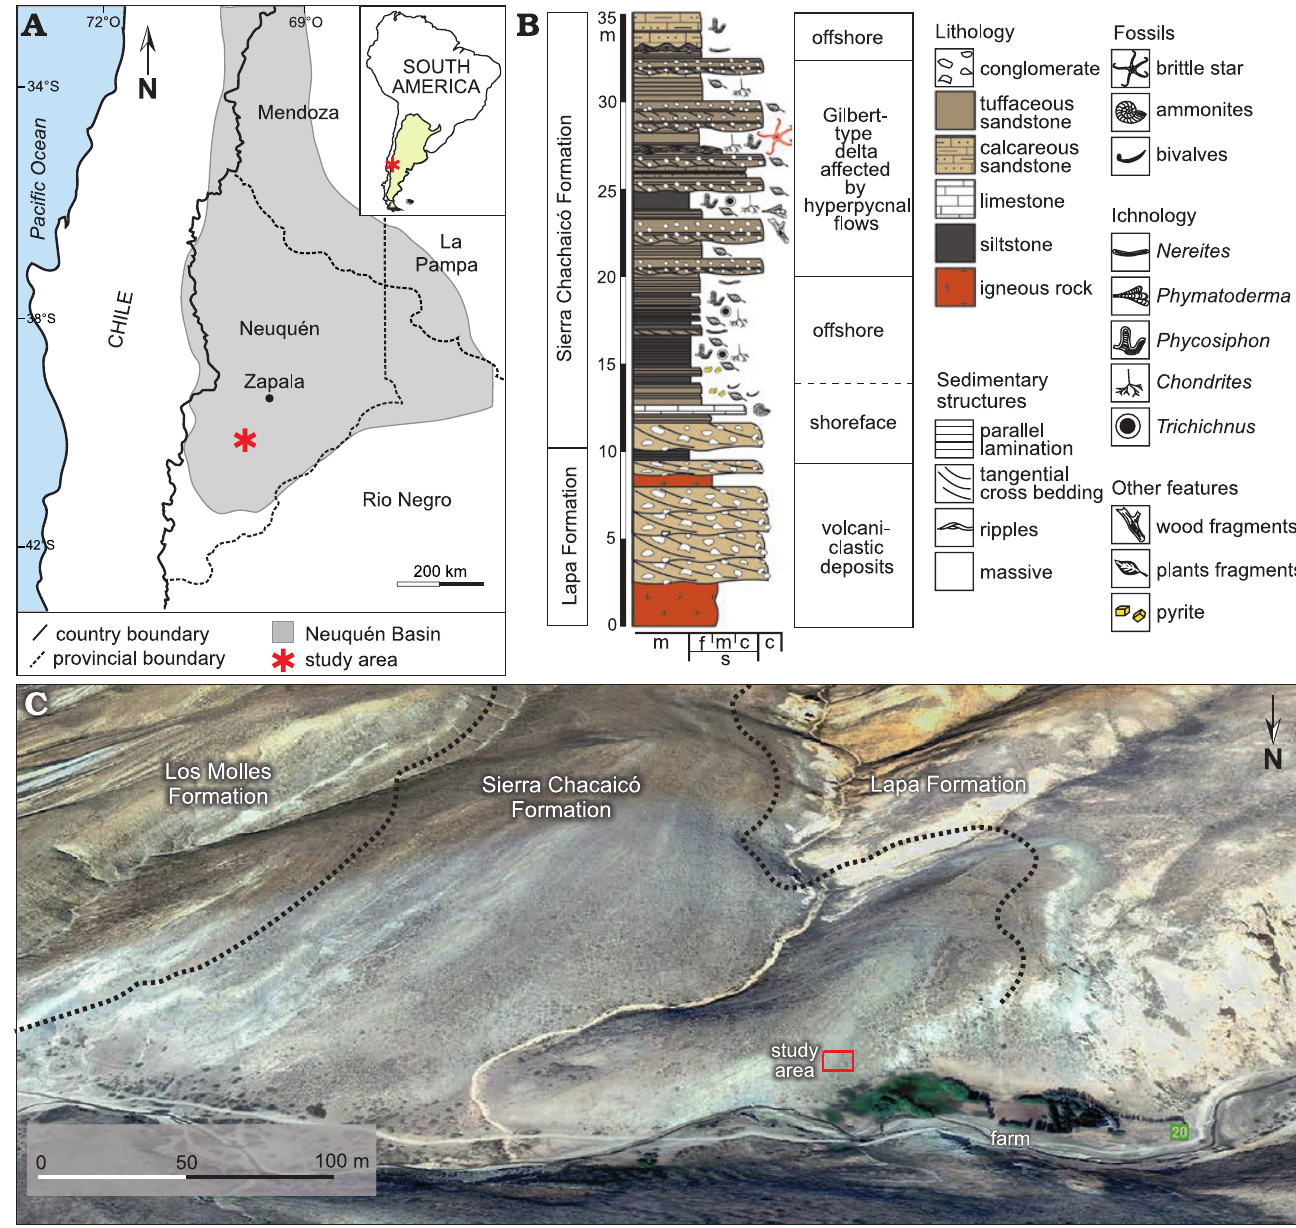
Fig. 1. Location and sedimentological section in the studied area. A . Location map of the Neuquén basin in west-central Argentina, showing the study area. B . Sedimentological section in the Arroyo Lapa locality, showing the massive levels where the ophiuroid specimen was collected. C . Satellite image of the Arroyo Lapa locality showing the boundaries of the Lapa, Sierra Chacaicó and Los Molles formations (Google Earth, access April